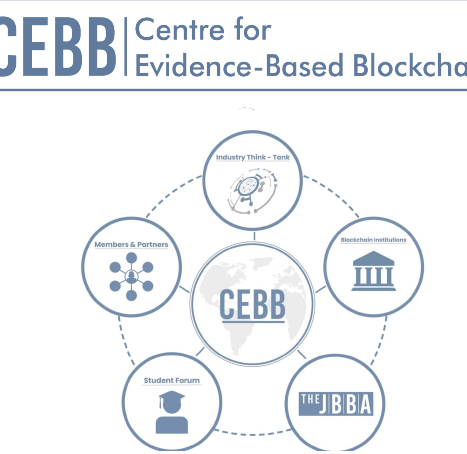
Figure 2. Centre for Evidence-Based Blockchain